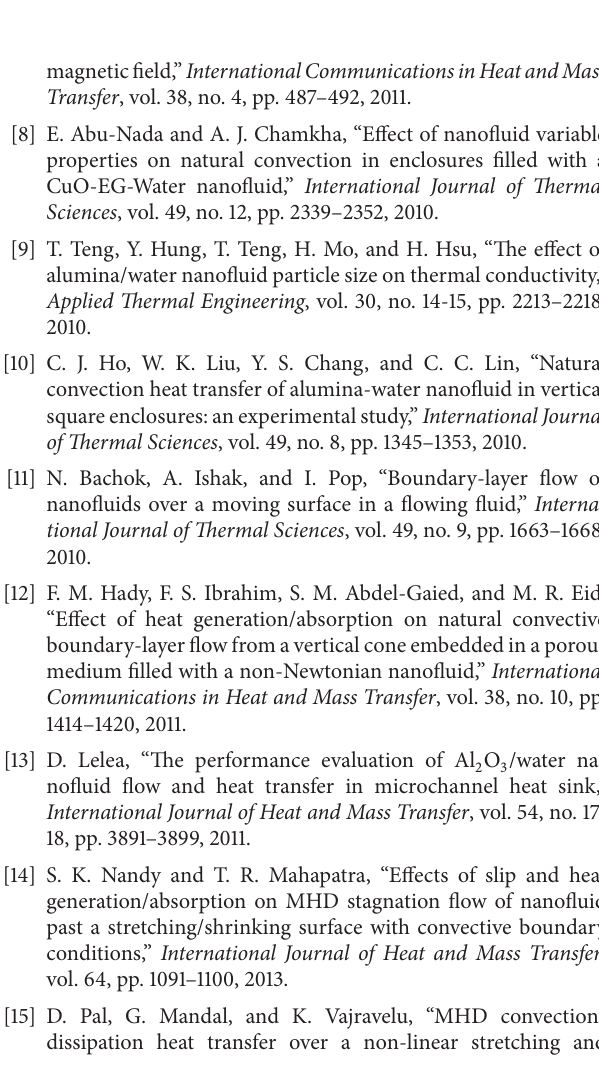
Figure 10: Pr = 6.2, M = 0.5, b = 0.5, and 𝜙 =